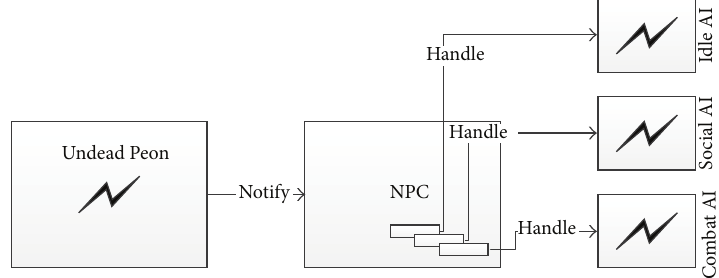
Figure 11: Event handling by AI controllers. Game events are projected into CDS before being pushed to AI